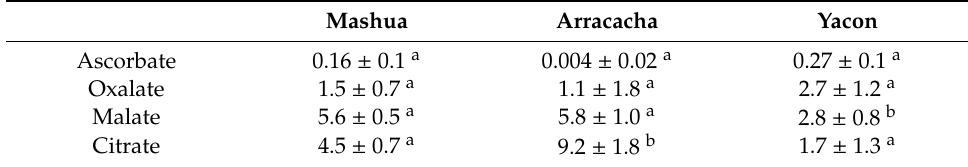
Table 4. Concentration of organic acids in Andean roots and tubers collected in Bolivia and Peru (in mg g dry matter − 1 ). Means followed with the same letter indicate not significant di ff erences among species (LSD, p <